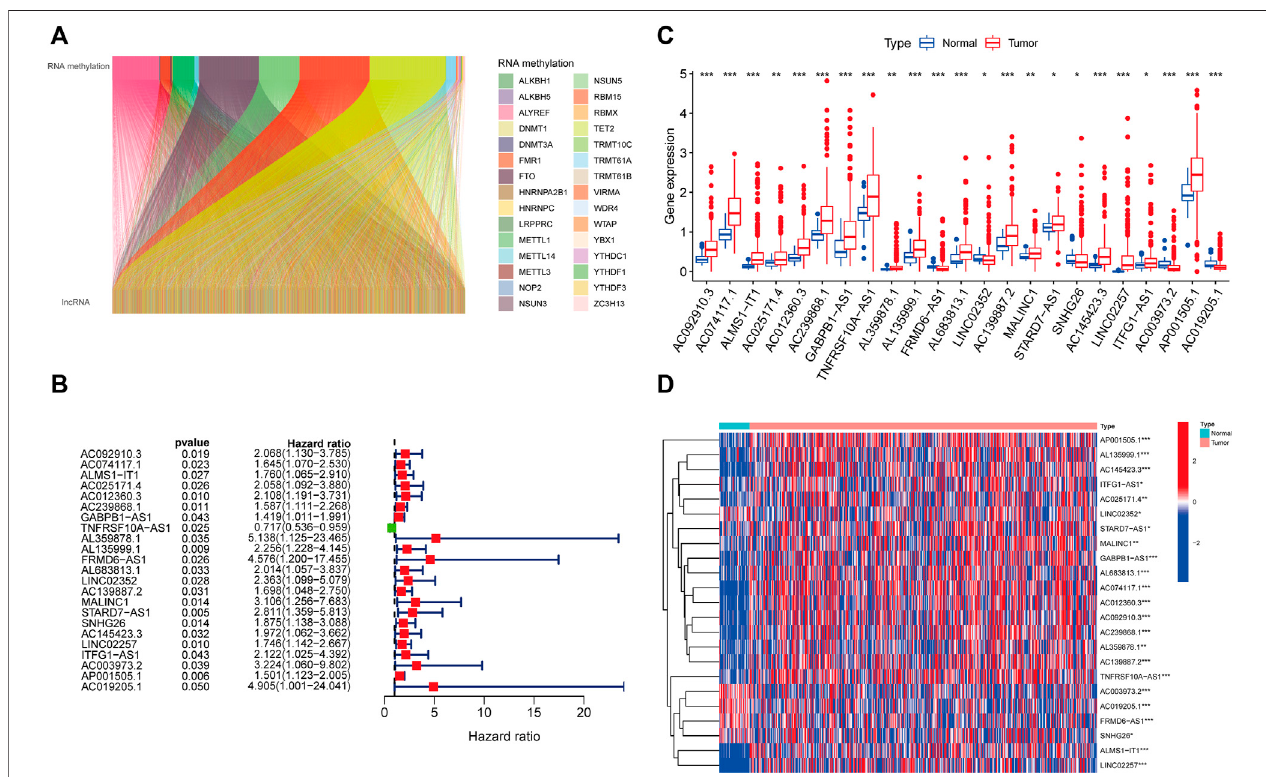
FIGURE 3 | Identi fi cation of prognostic value of RNA methylation-related lncRNAs. (A) 1,057 lncRNAs were co-expressed with differentially expressed RNA methylation-related regulators. (B) Univariate Cox regression analysis screened 23 lncRNAs with prognostic value. (C,D) The boxplot and heatmap of 23 lncRNAs with prognostic value differentially expressed between 41 normal and 471 tumor tissues in the TCGA-CORD cohort. *p < 0.05; **p < 0.01; ***p < 0.001; ns, no sense.